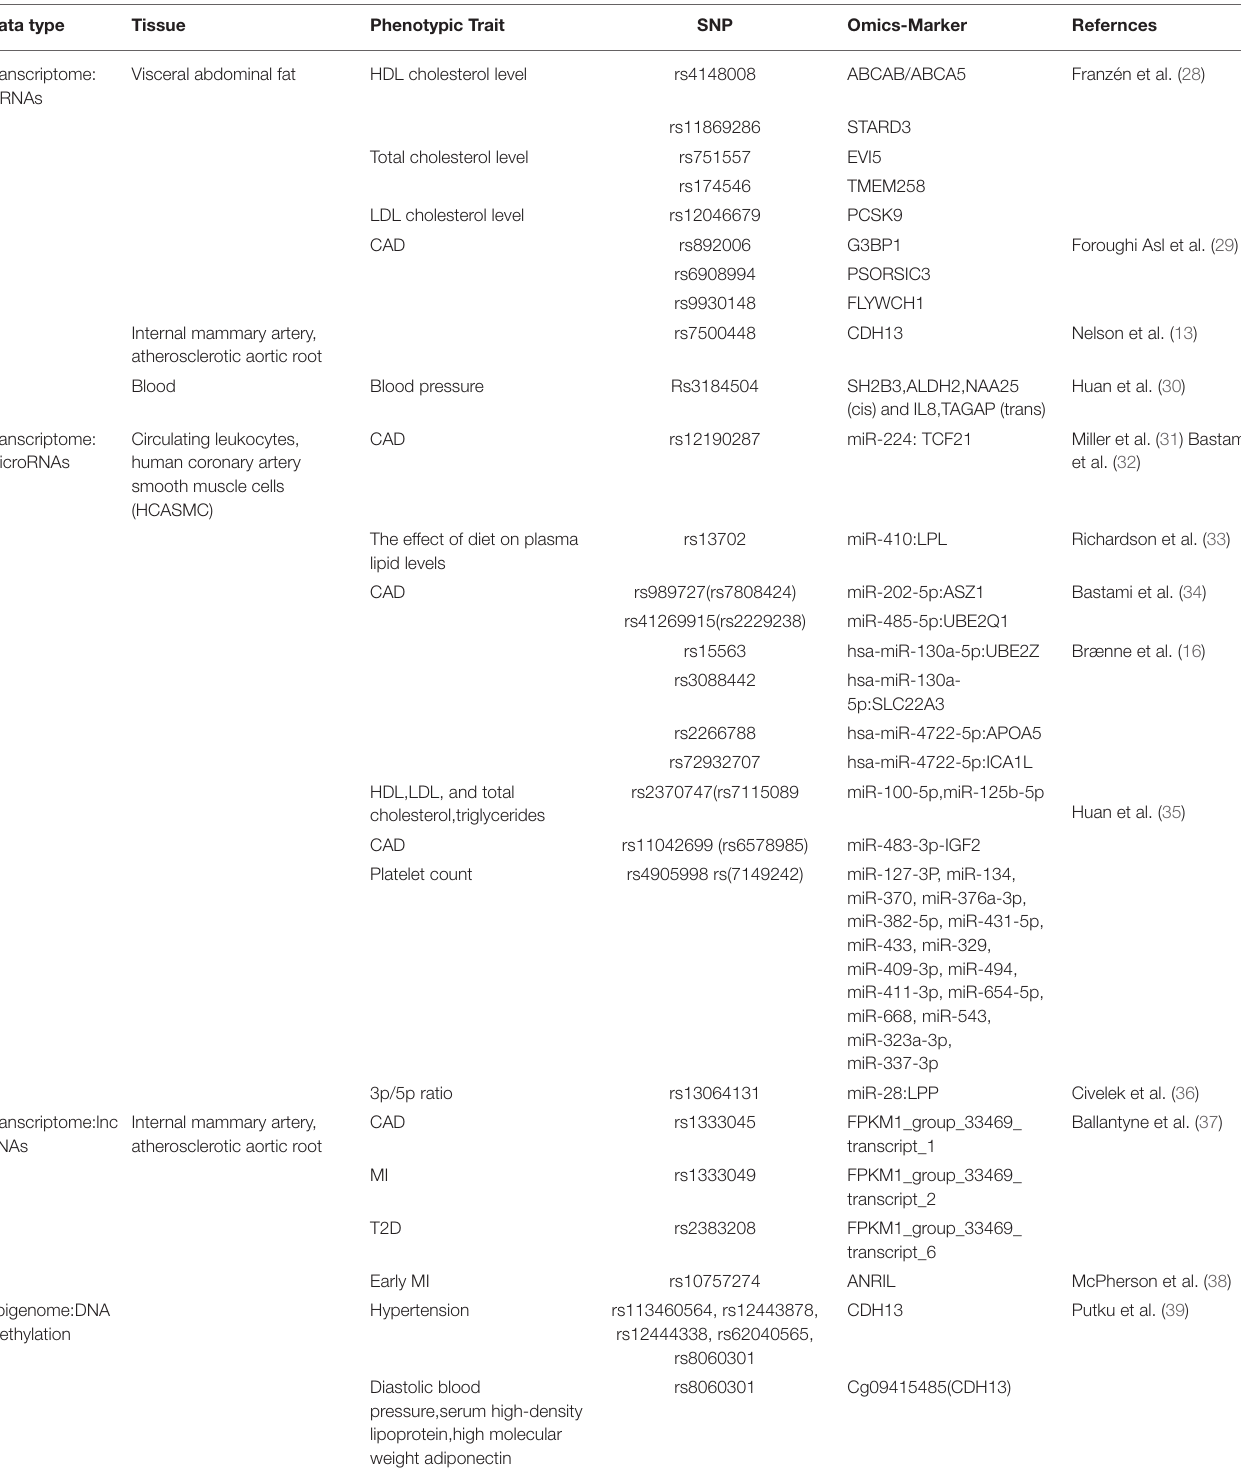
TABLE 1 | Genetic variation related to CAD/MI risk that has been associated with other down-stream omics layers such as transcriptome (mRNA, microRNAs and lncRNAs), epigenome, proteome or metabolome. Data